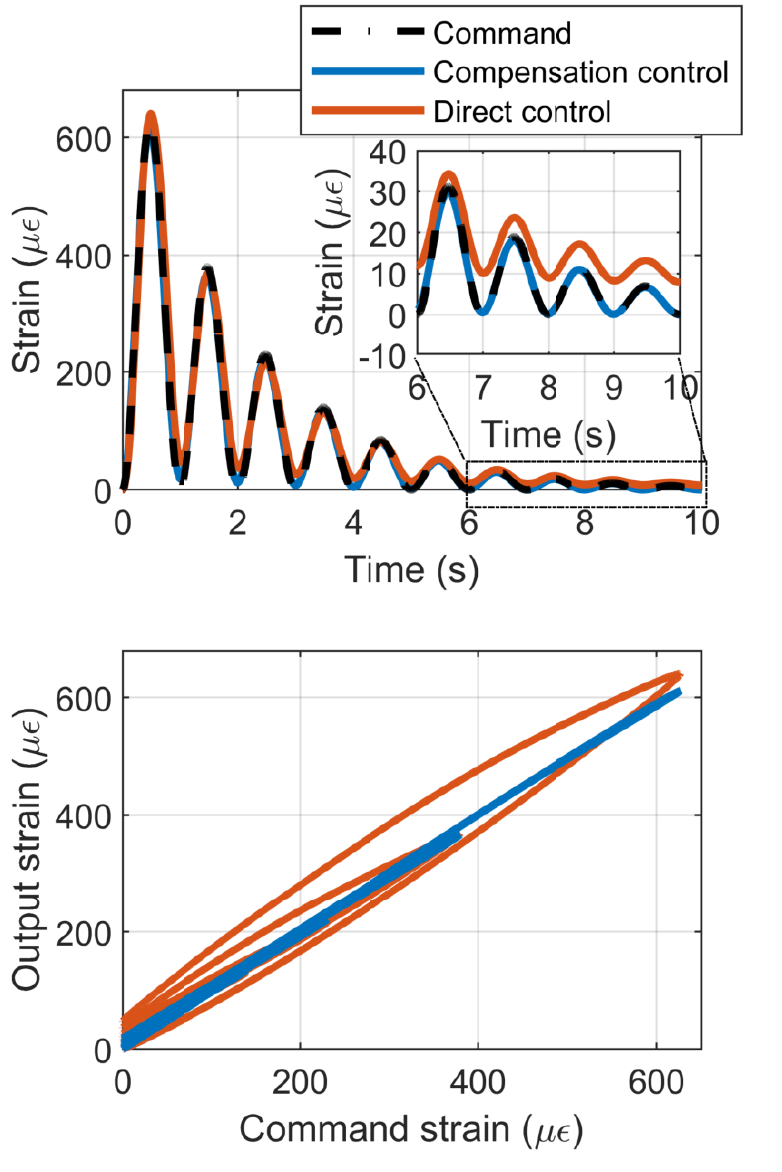
Figure 16. Control using compensation considering time-dependent magnitude strain